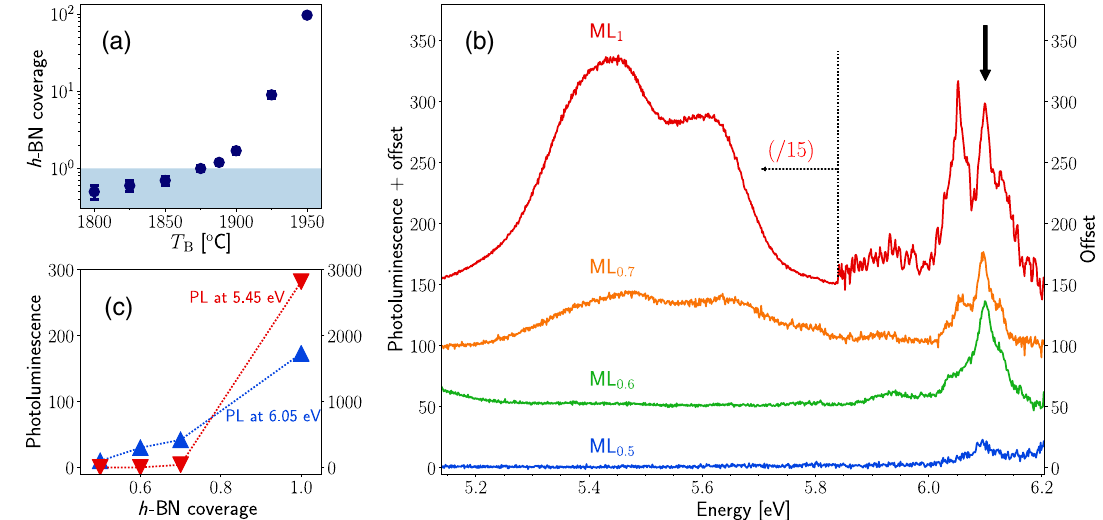
FIG. 2. (a) h -BN coverage in units of a continuous monolayer as a function of the boron cell temperature T , for a growth temperature B 1390 °C and a growth time of 3 h. Below one (shaded blue region), the h -BN coverage corresponds to the fraction of the substrate T g ¼ surface covered by h -BN. (b) Photoluminescence spectra after subtraction of laser diffusion for the atomically thin h -BN epilayers with a ∼ 6 . 41 eV. The offset is 0, 50, 100, and 150 for samples ML coverage below unity, at 8 K for an excitation energy E 0 . 5 , ML 0 . 6 , ML 0 . 7 , ex and ML 1 , respectively. The vertical arrow indicates the Raman-shifted energy E - 2 Δ , with Δ ¼ 156 meV, corresponding to the energy ex of the LA(M) phonon in h -BN. (c) Photoluminescence intensity at 6.05 eV (blue up triangles) and at 5.45 eV (red down triangles) as a function of the h -BN coverage.